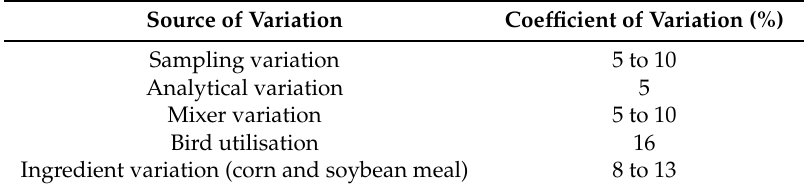
Table 6. Summary of variation in processes associated with feeding of phosphorus to broilers